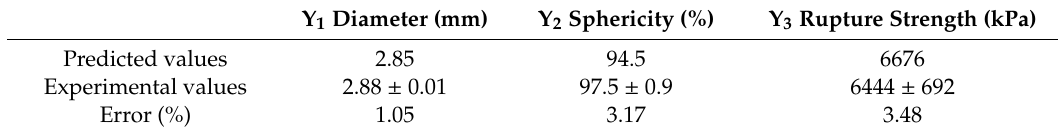
Table 8. Verification of experimental and predicted values under optimal conditions.